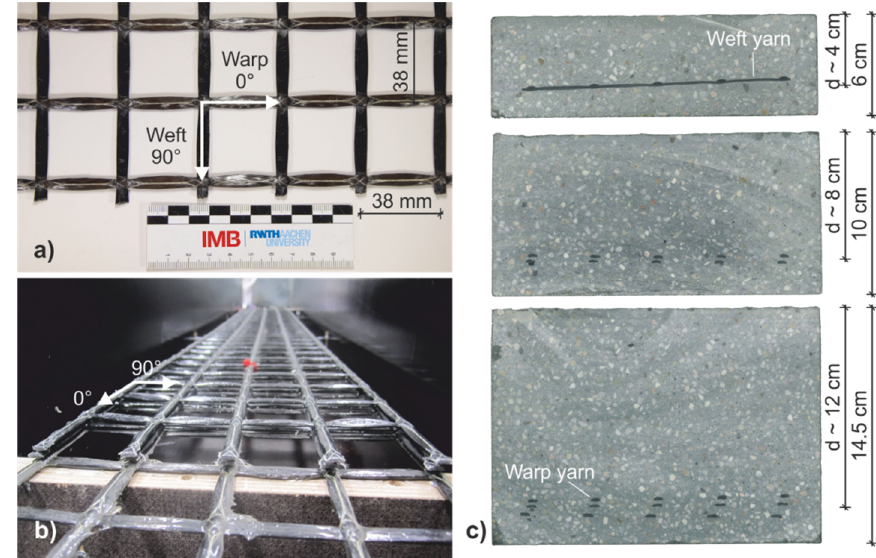
Figure 2. Reinforcement layout for test series: ( a ) Planar biaxial grid made of carbon with epoxy impregnation; ( b ) formwork with bottom reinforcement layer projecting beyond the end; ( c ) cross-section of the three specimen types.